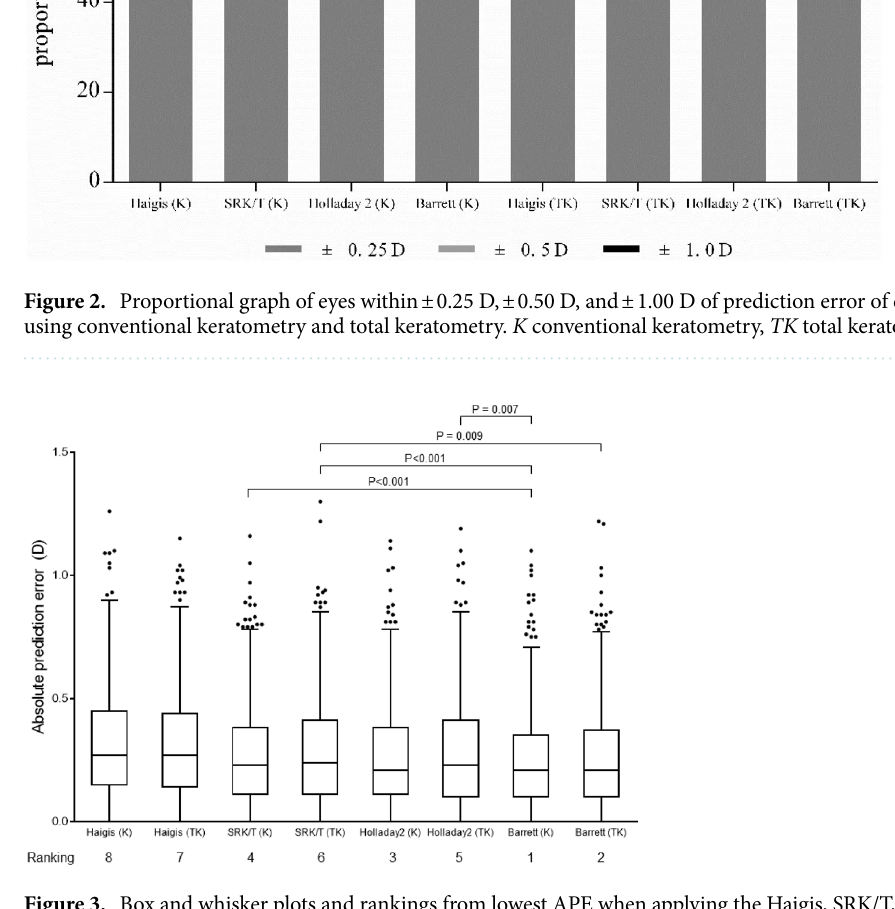
Figure 3. Box and whisker plots and rankings from lowest APE when applying the Haigis, SRK/T, Holladay 2, and Barrett Universal II/Barrett TK Universal II formulas using K and TK. P-values adjusted for use of multiple comparisons are indicated in this figure. K conventional keratometry, TK total keratometry.